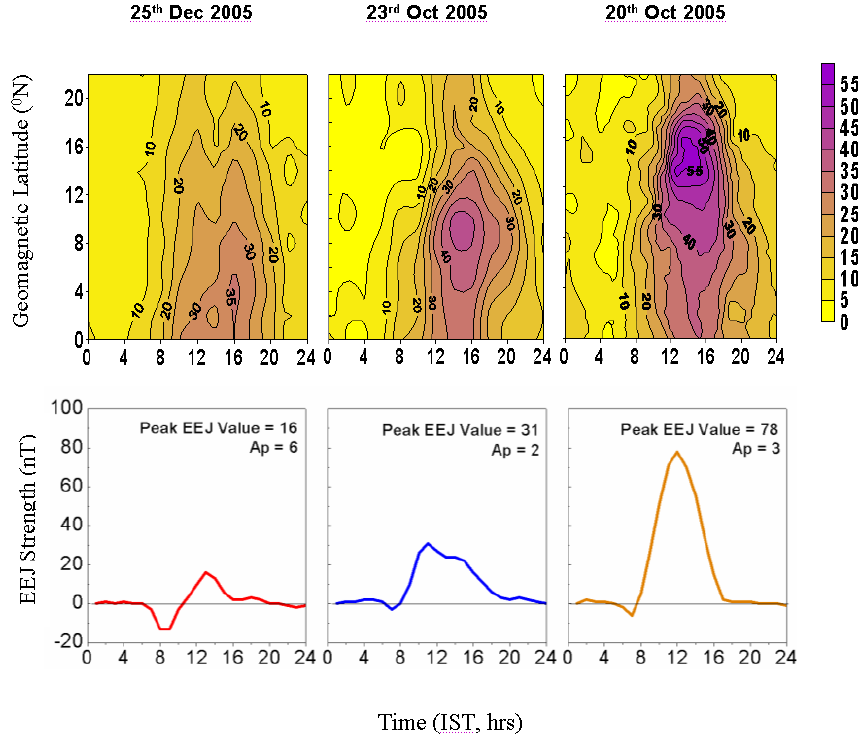
Fig. 9. Equatorial Ionization Anomaly development using GAGAN GPS data for different days showing its dependence on EEJ.